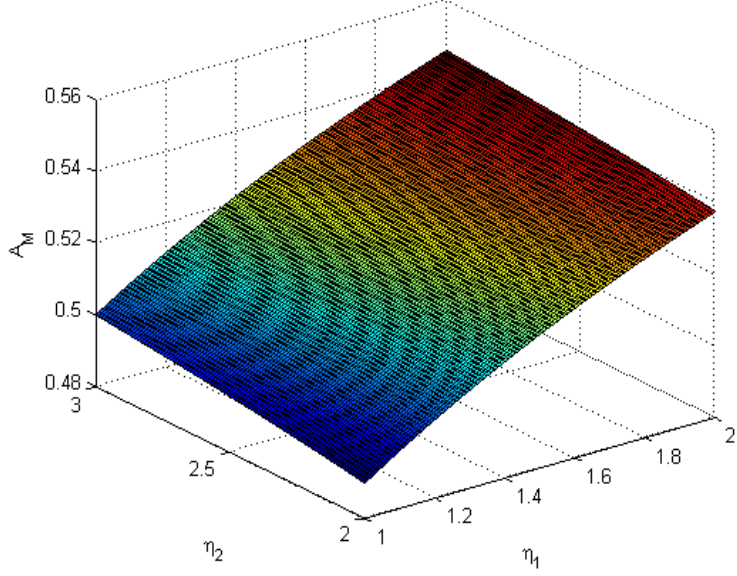
Figure 1. The steady-state availability of the machine ( A M ) for λ = 1, µ = 2, ξ 1 = 1 and ξ 2 = 1.5.